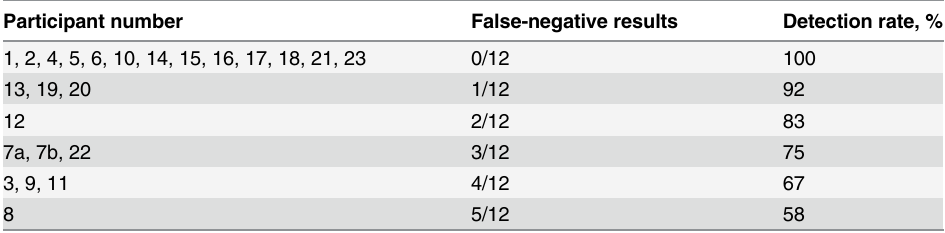
Table 3. LASV detection rate by participant.